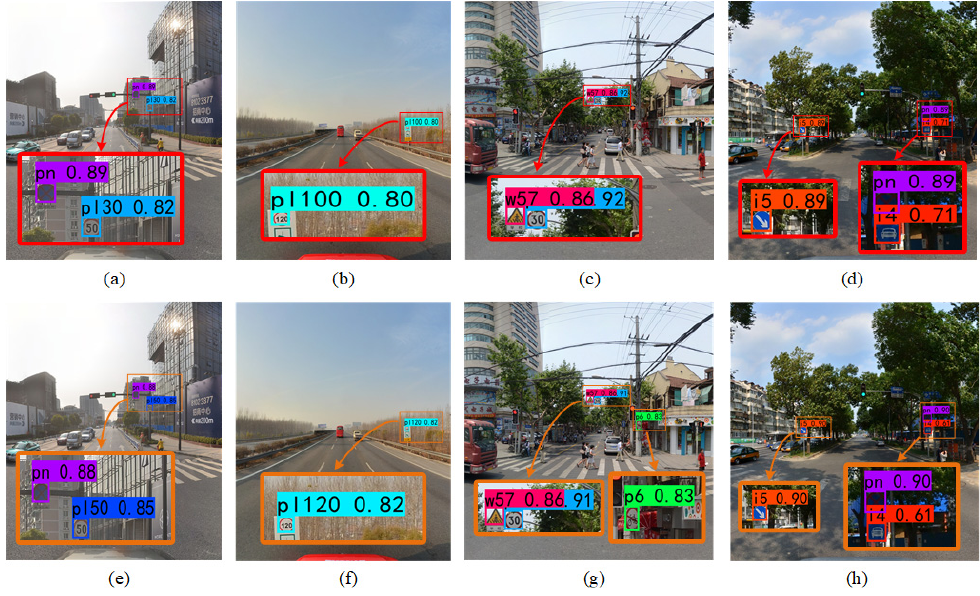
Figure 5. The visualization results: ( a – d ) YOLOv5; ( e – h ) AIE ‐ YOLO.